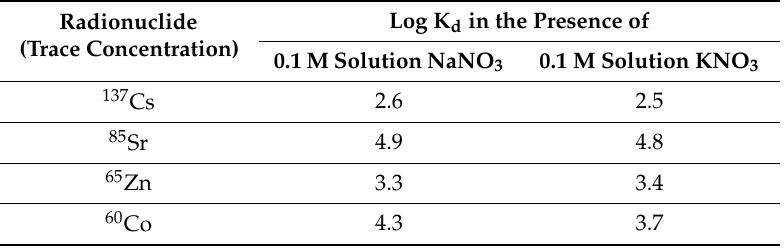
Table 1. Comparison of log( K d ) of the main radionuclides present in decontamination fluid solutions containing competitive Na + and K + cations at pH = 4.